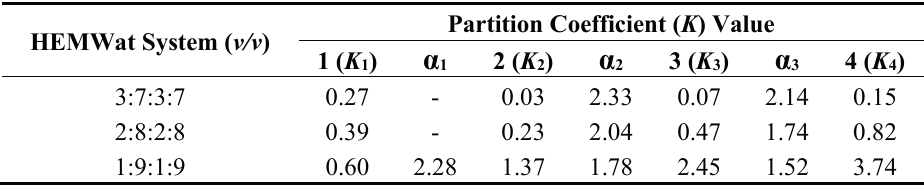
Table 1 . Partition coefficient values ( K ) of compounds 1 – 4 in n -hexane–ethyl acetate– methanol–water (HEMWat) systems. Peaks 1 : caffeine, 2 : ( − )-epigallocatechin 3- O -gallate, 3 : ( − )-gallocatechin 3- O -gallate, and 4 : ( − )-epicatechin 3- O -gallate. ( α : separation factor;